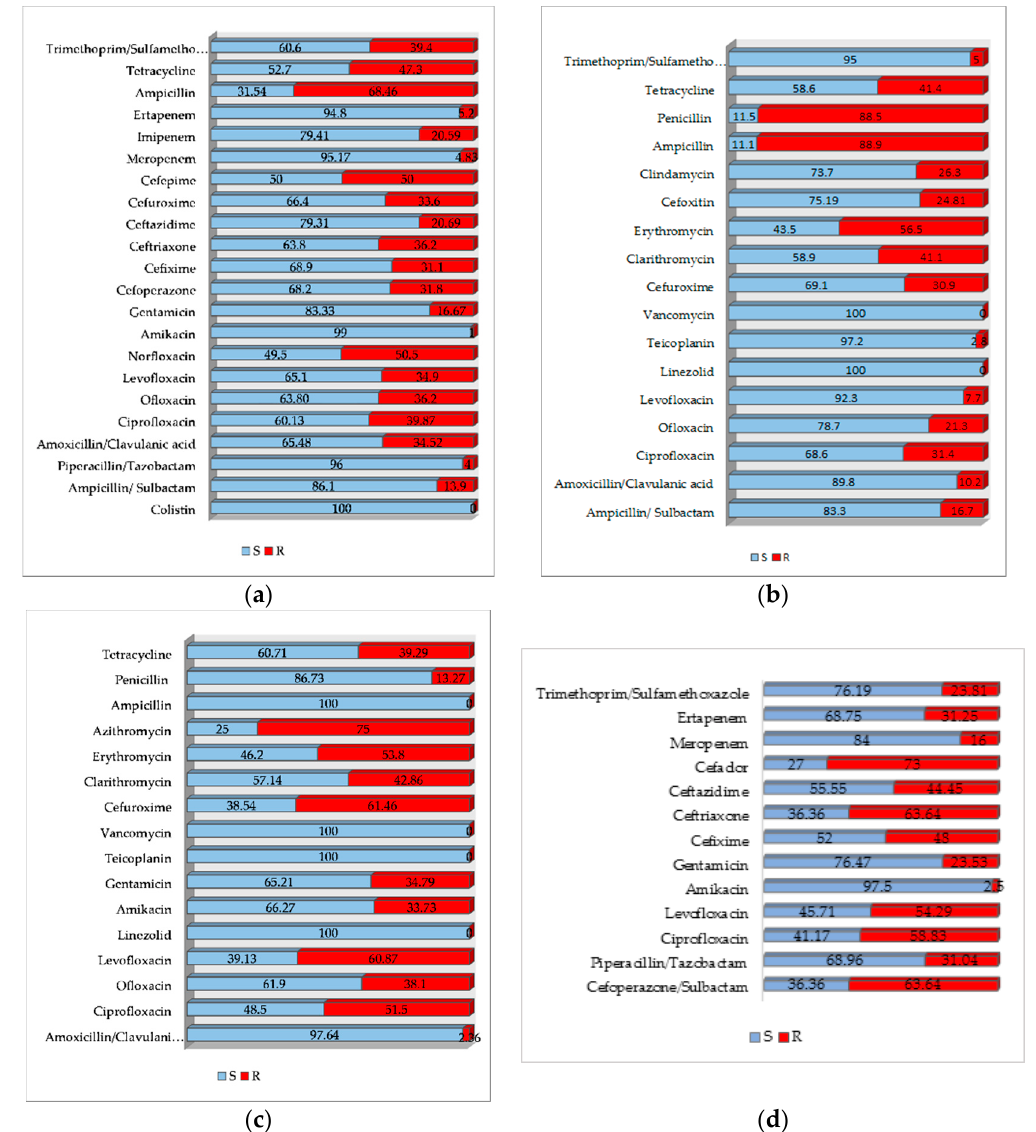
Figure 2. Antibiotics resistance/susceptibility profile for: ( a ) E. coli ; ( b ) S. aureus ; ( c ) E. faecalis ; ( d ) Klebsiella